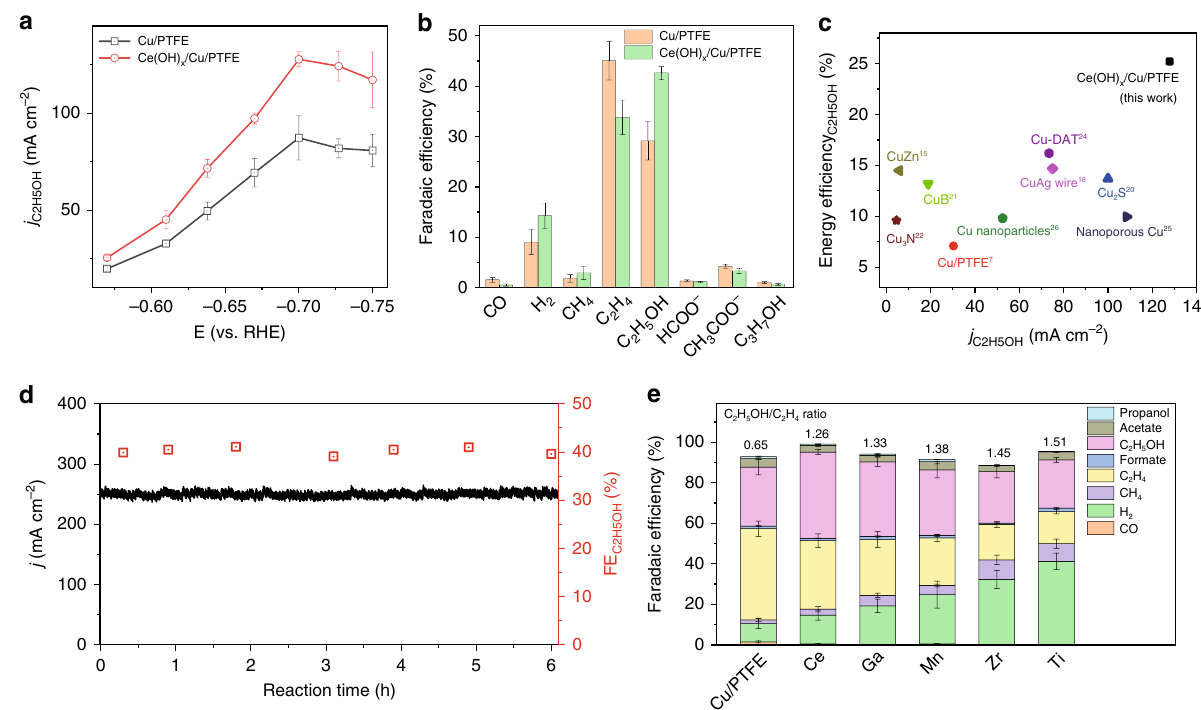
Fig. 3 Carbon dioxide electroreduction performance. a Partial ethanol current density of Ce(OH) x /Cu/PTFE and bare Cu/PTFE under various potentials. b Product distribution of Ce(OH) x /Cu/PTFE and bare Cu/PTFE at the − 0.7 V versus RHE. c Energy ef fi ciency as a function of partial current density on Ce (OH) x /Cu/PTFE, in comparison with other reports with operational current density higher than 10 mA cm − 2 . d i – t curve (left axis) of Ce(OH) x /Cu/PTFE catalyst along with corresponding Faradaic ef fi ciency of ethanol (right axis). e Product distribution of various hydroxides/oxides modi fi ed Cu/PTFE electrode, along with corresponding C 2 H 5 OH/C 2 H 4 ratio. The error bars represent the standard deviation from at least three independent